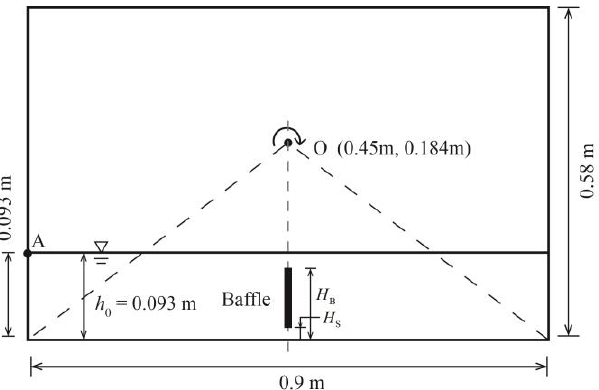
Figure 1. Initial conditions for liquid sloshing simulation under a rotational excitation.